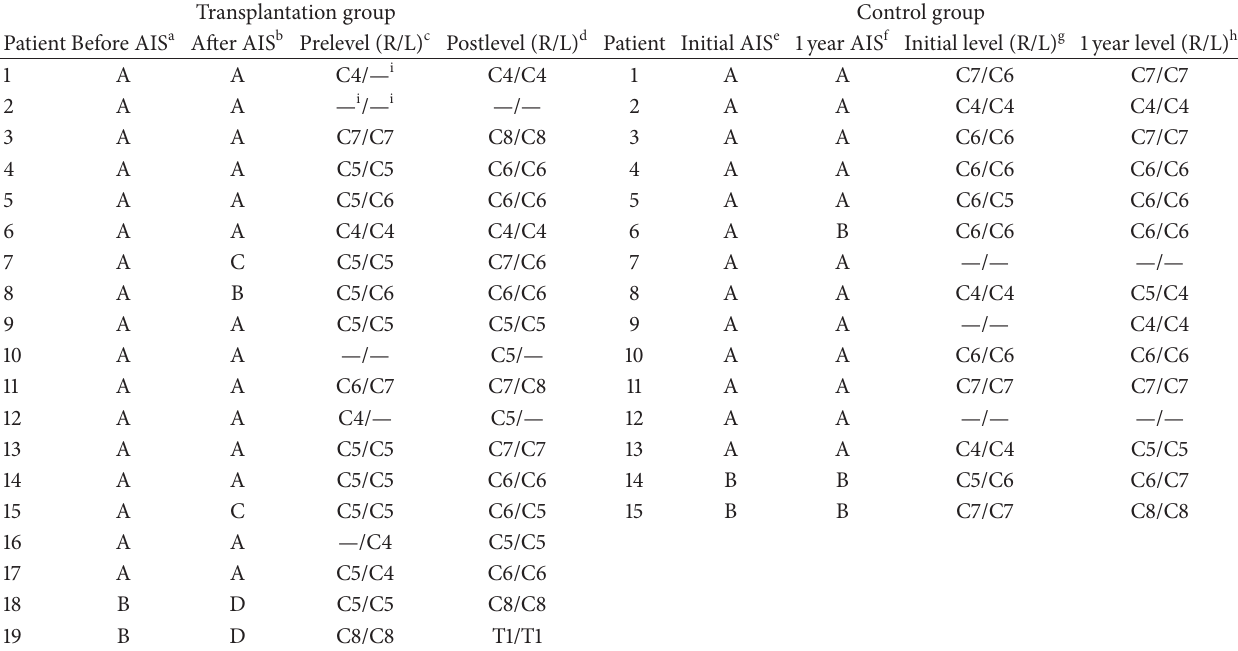
Table 4: AIS grade conversion and motor level changes after cervical SCI. Transplantation group Control group